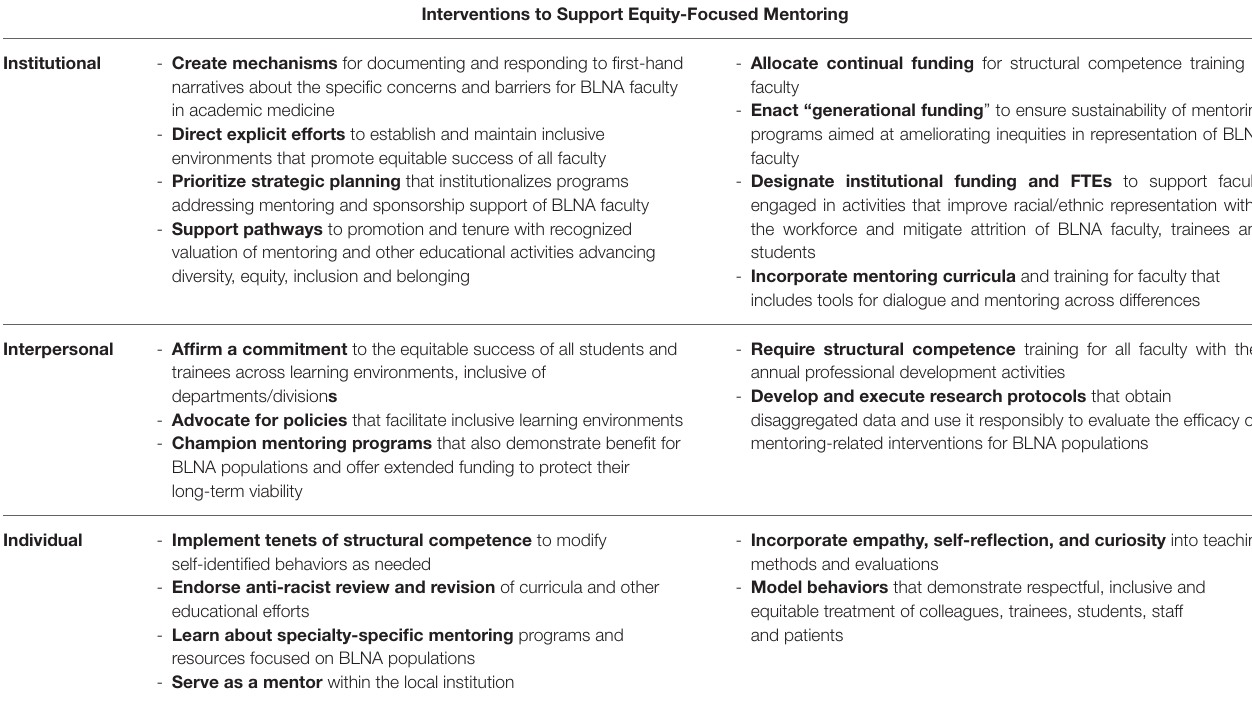
TABLE 1 | Interventions to support equity-focused